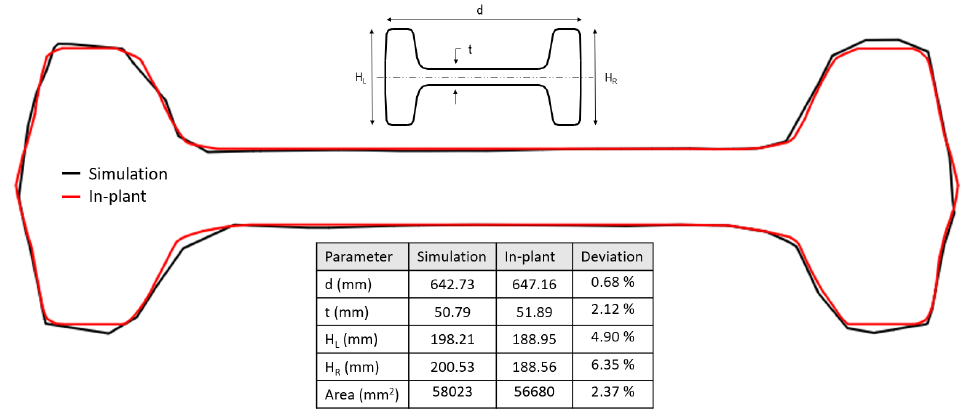
Figure 14. Comparison of the final cross-section of the beam for the simulation T.Real and in- plant